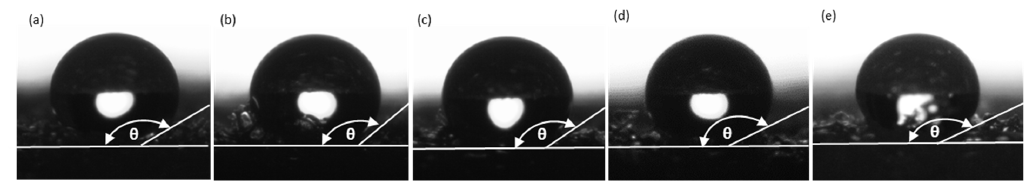
Figure 13. The contact angle of ( a ) F_EF_0, ( b ) F_EF_NT, ( c ) F_EF_A, ( d ) F_EF_M, ( e ) F_EF_S.